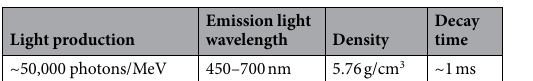
Table 1. Physical properties of GAP/ α -Al 2 O 3 fiber scintillator plate.